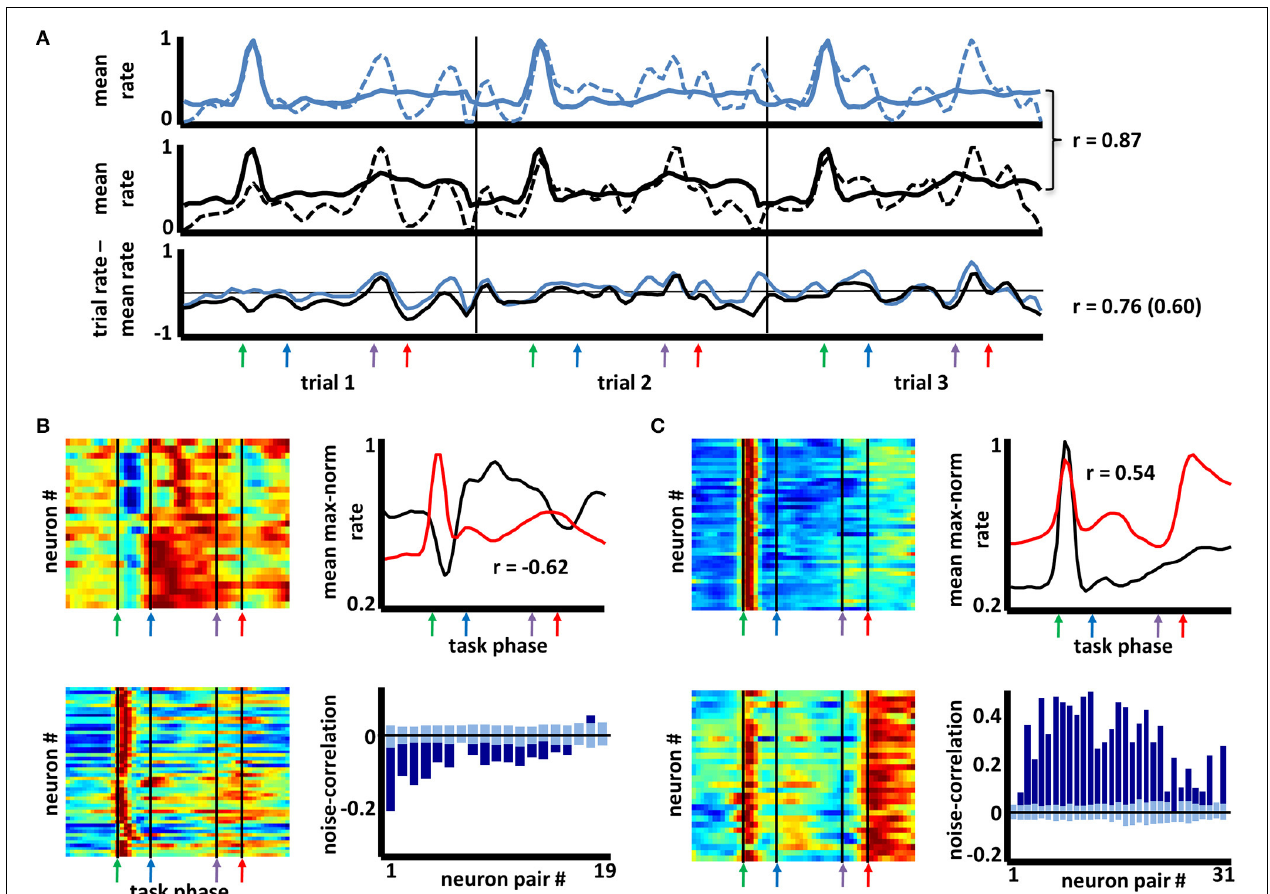
FIGURE 5 | Noise correlation among basal forebrain neurons having similar or dissimilar firing patterns. (A) Upper and middle panels depict max-normalized firing rates for two simultaneously-recorded basal forebrain neurons across three consecutive trials (dashed lines in each; thin vertical lines separate trials). Thick lines depict, in repeating fashion, the cross-trial firing rate means for the same two neurons. The mean firing patterns for the two neurons are strongly correlated ( r = 0 . 87). Lower panel depicts subtractions of each neuron’s single trial rates from their cross-trial mean rates. The deviations from the mean for the two neurons are correlated across the three trials ( r = 0 . 76) as well as across all trials ( r = 0 . 60). (B) Color maps depict task-phase-specific firing rates for individual members of two